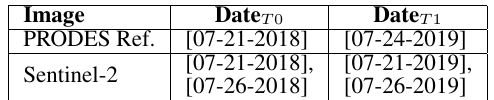
Table 1. Acquisition dates of the Sentinel-2 images of the Par´a state, and dates of the PRODES reference